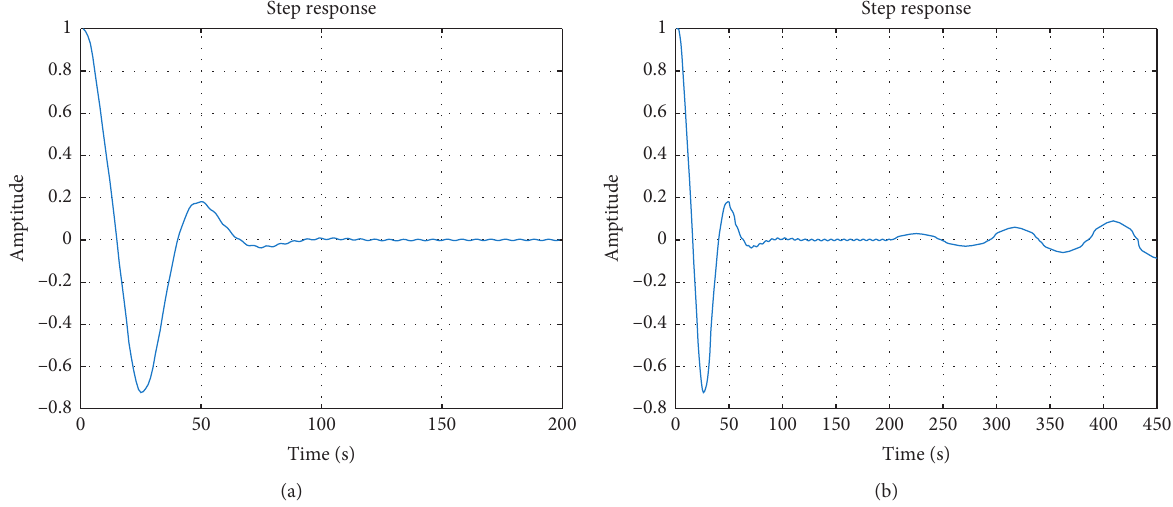
Figure 9: System response under step disturbance with/without perturbation. (a) The response curve of the nominal system. (b) The response curve of the system with